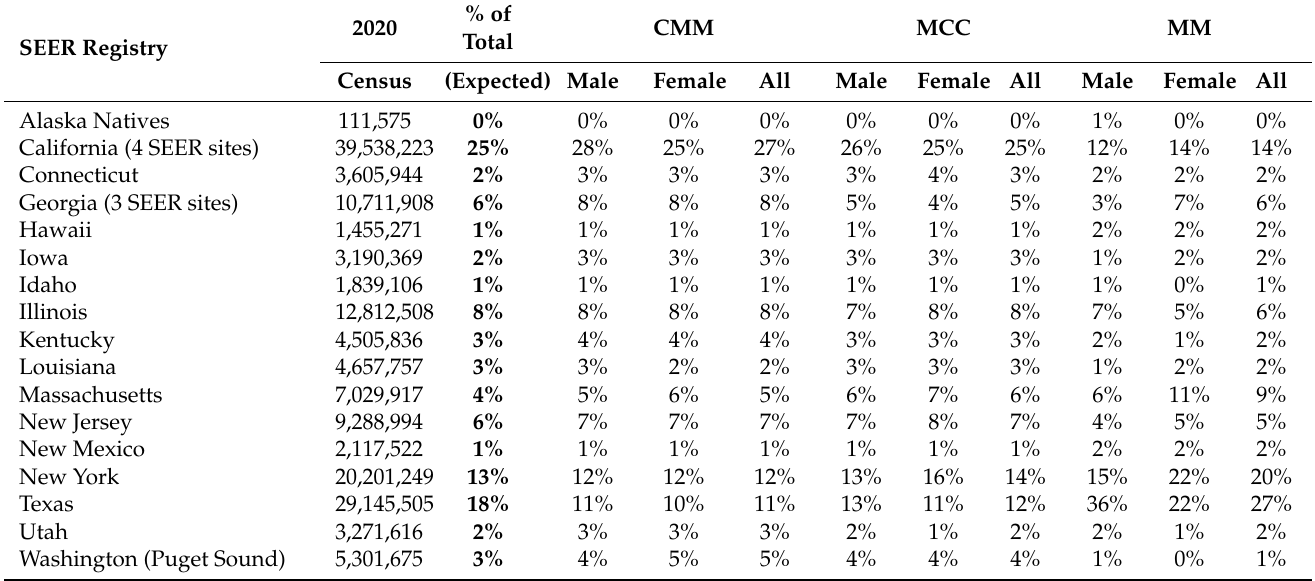
Table 2. Percentages of cutaneous malignant melanoma (CMM), Merkel cell carcinoma (MCC)